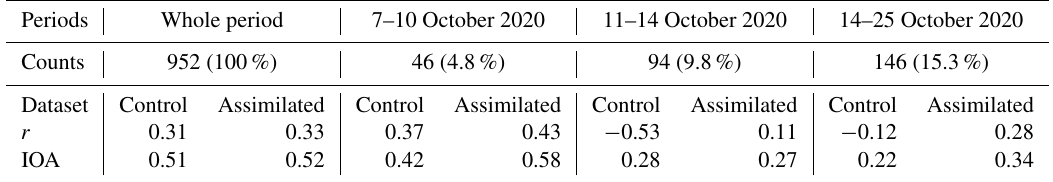
Table 1. Statistical comparison of modelled runs with PM 10 concentrations recorded at Agia Marina station, Cyprus, for the whole period and the highlighted time